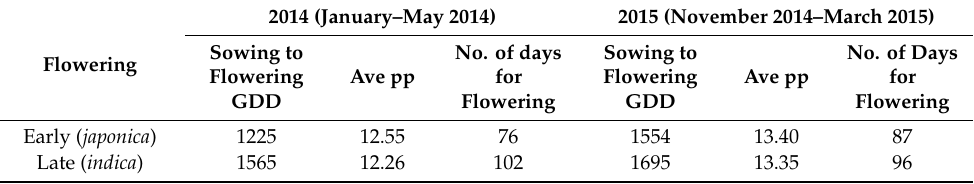
Table 7. Average growing degree days (GDDs), photoperiod (pp), and number of days from sowing to flowering of rice varieties under strategic irrigation and rainfed conditions at Alton Downs, 2014 and